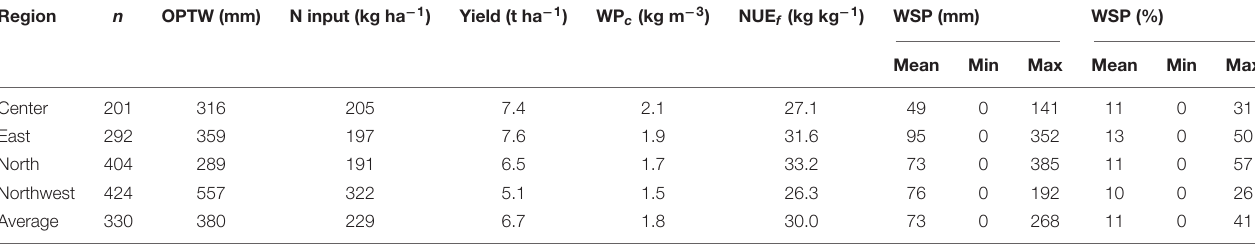
TABLE 1 | Estimated mean water saving potentials (WSPs) of a specific region (for details, see Figure 1 ). Region n